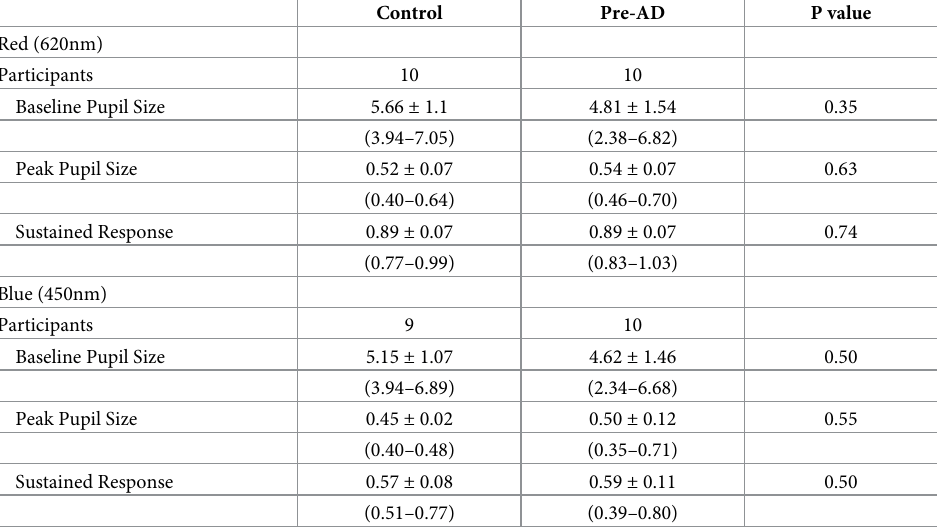
Table 2. Chromatic pupillometry data for controls and pre-AD.